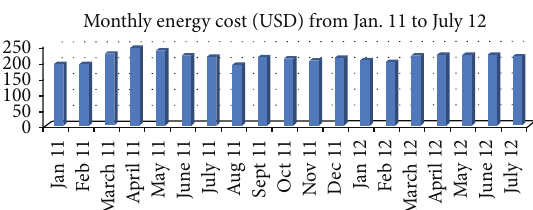
Figure 8: Estimation costs curve for monthly energy consumption, MTN Maroua Market site from January 11 to July